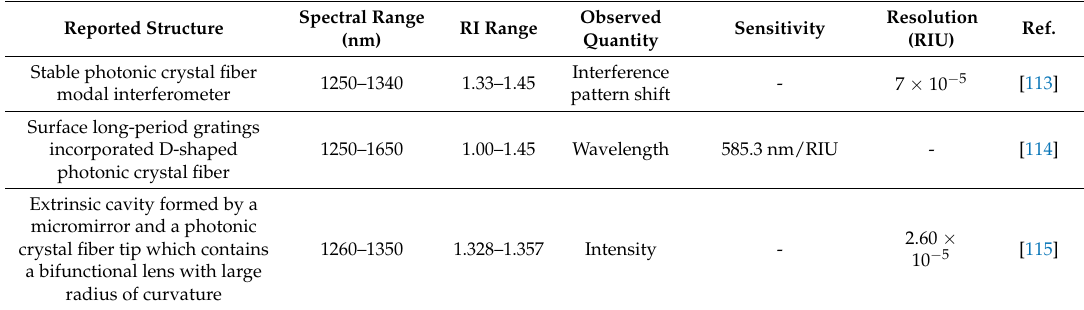
Figure 43. Selectively gold layer coated (around large cavity) birefringent PCF sensing probe used for RI measurement (Reproduced from [112], with the permission of OSA publishing). Table 4. Collective representation of various PCF-based refractive index sensors.